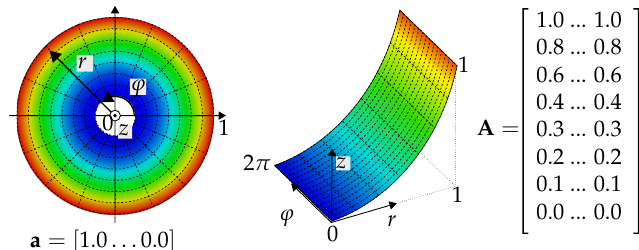
Figure 3. Decomposition of a proper mode shape into the two parts of the Z ERNIKE polynomial.